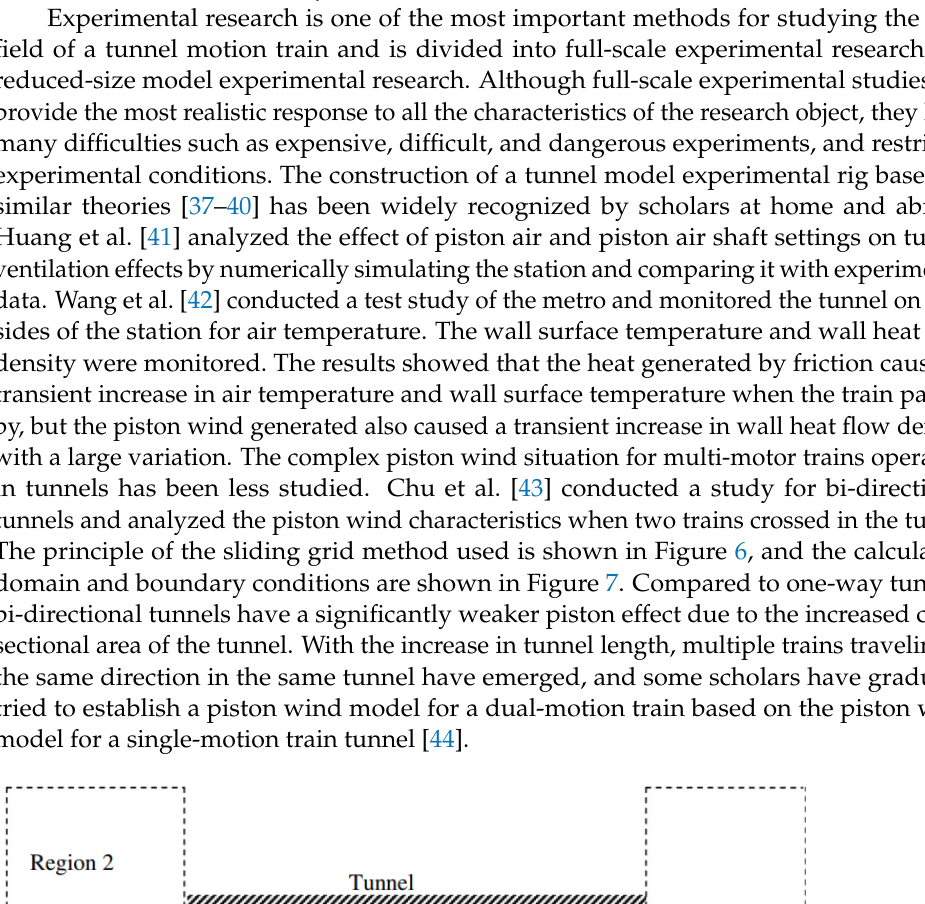
Figure 7. Schematic diagram of computational domain and boundary condition.[43]. In the above studies, the possible existence of curves, slopes and ventilation shafts in tunnels has not been taken into account; therefore, a more comprehensive study of piston wind laws under a variety of tunnel characteristics should be carried out. In addition, in- depth research on piston wind laws should be carried out by means of full-size tunnel experiments, etc. Experimental studies of full-size real tunnels are necessary, and their experimental data will be an important support for piston wind studies of tunnel motion trains. In the normal operation of a long tunnel, if the piston air can be effectively used, the energy consumption of ventilation will be saved. However, in the process of evacua- tion, rescuing a train from a fire rescue station, the train will go from a constant speed through slowing until it stops, and the tunnel piston wind will demonstrate various forms